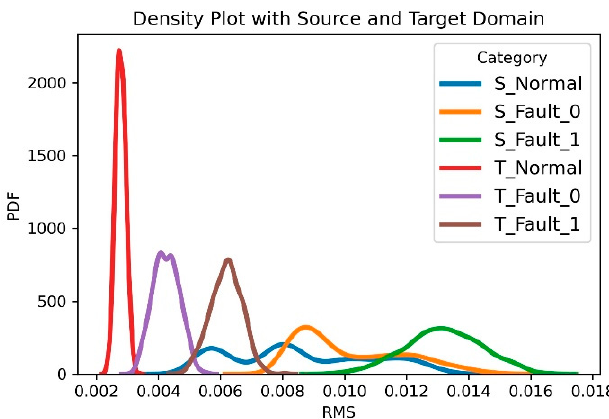
Figure 5. A data distribution plot for the failure modes of a gearbox with two working conditions in a real machine dataset. The source domain data is denoted S_Normal, S_Fault_0, S_Fault_1; the target domain data is denoted T_Normal, T_Fault_0, and T_Fault_1.